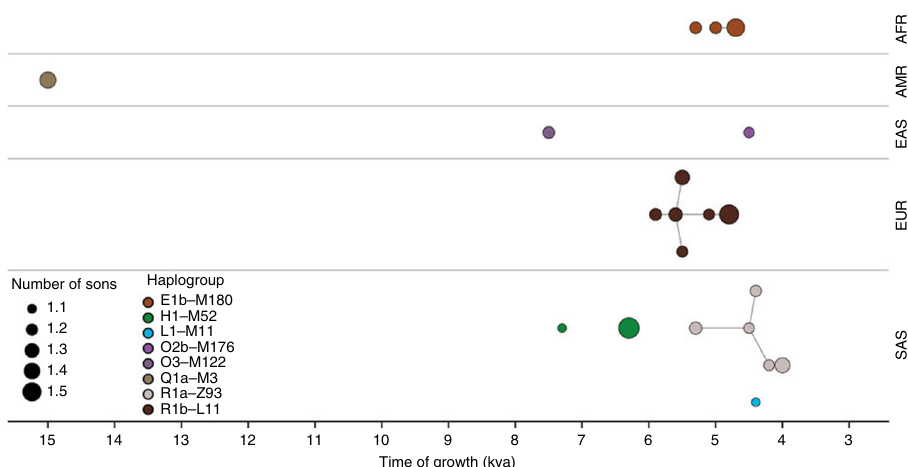
Fig. 2 Explosive male-lineage expansions of the last 15,000 years. Each circle represents a phylogenetic node whose branching pattern suggests rapid expansion. The horizontal axis indicates the timings of the expansions, and circle radii re fl ect growth rates, namely the minimum number of sons per generation, as estimated by a two-phase growth model of Poznik et al. 6 . Nodes are grouped by continental superpopulation (AFR: African, AMR: admixed American, EAS: East Asian, EUR: European, SAS: South Asian) and coloured by haplogroup. Line segments connect phylogenetically nested lineages. Reprinted from Poznik et al. 6 with permission from Carlos D. Bustamante and Nature Publishing